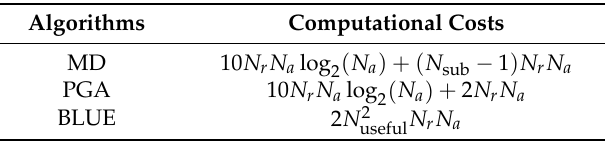
Table 4. Computational costs of different